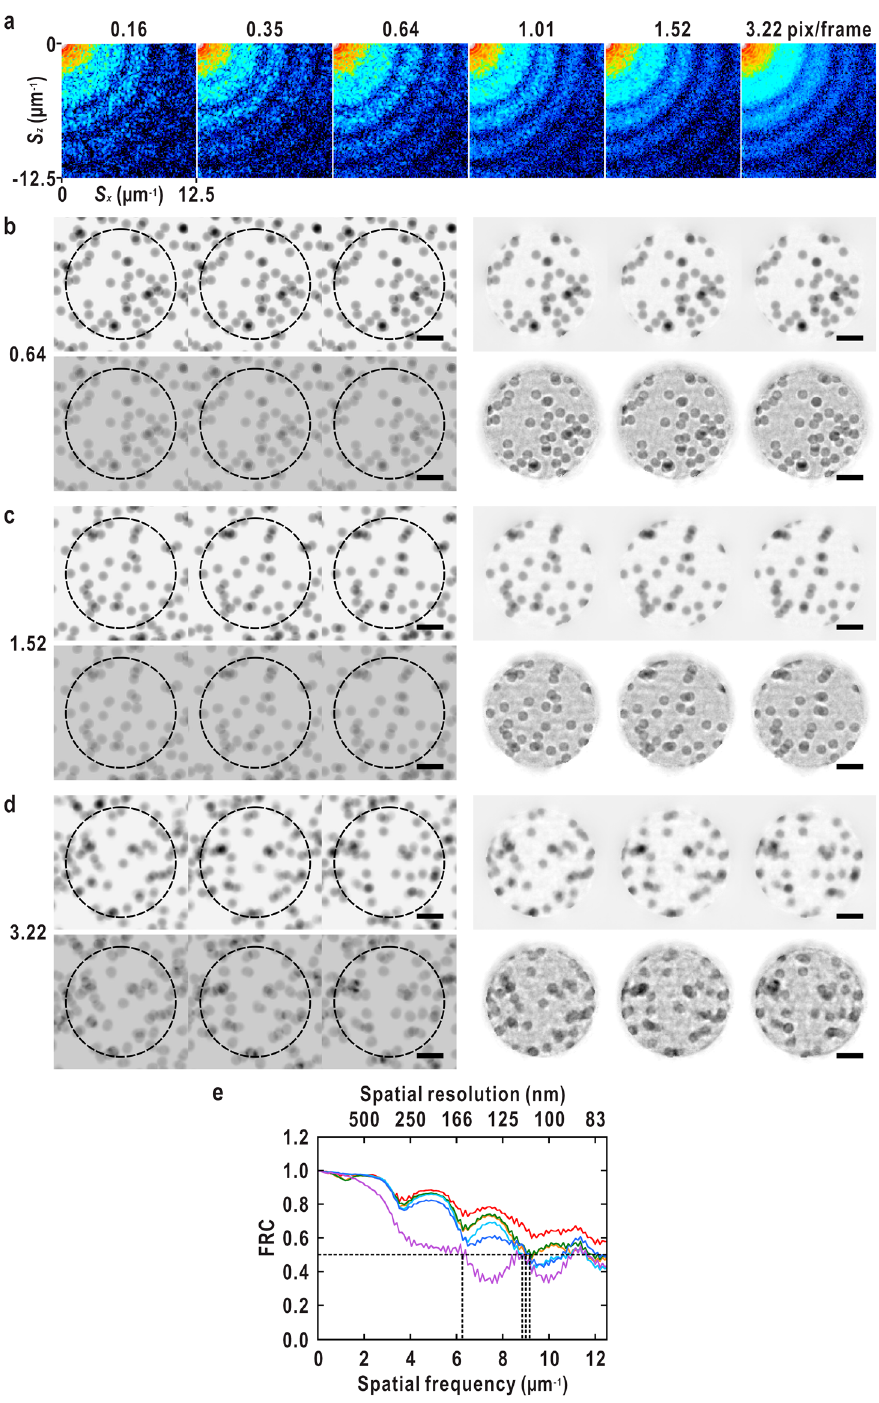
Fig. 6 Effect of the amount of structural variation on multiple-shot coherent diffraction imaging. a Simulated diffraction intensity patterns of each model accumulated over the dwell time. The root mean square displacements (RMSDs) of the models are indicated at the top. Object transmission functions of the models averaged over the frame time (left) and the corresponding reconstructions by the multiple-shot coherent diffraction imaging with multiple- frame ptychographic iterative engine with total-variation regularisation (mf-PIE-TV) (right) at a glycerine concentration and temperature of b 90%w/v and 323 K, c 80%w/v and 343 K, and d 50%w/v and 343 K, respectively. Phase (upper) and absorption (lower) images of three successive frames at frame numbers 499 – 501 are shown. The illuminated area on the models are indicated with the broken circles. The RMSDs of each model are indicated on the left in pixels per frame. e Temporal-averaged Fourier ring correlation (FRC) curves of each model, plotted in order of increasing the RMSDs with the red, orange, green, light blue, blue, and purple solid lines. The broken line indicates a 0.5 threshold and corresponding spatial frequency. The colour scale for the diffraction patterns and grayscale for the object images are same as those in Fig. 4. Scale bars indicate 1 μ